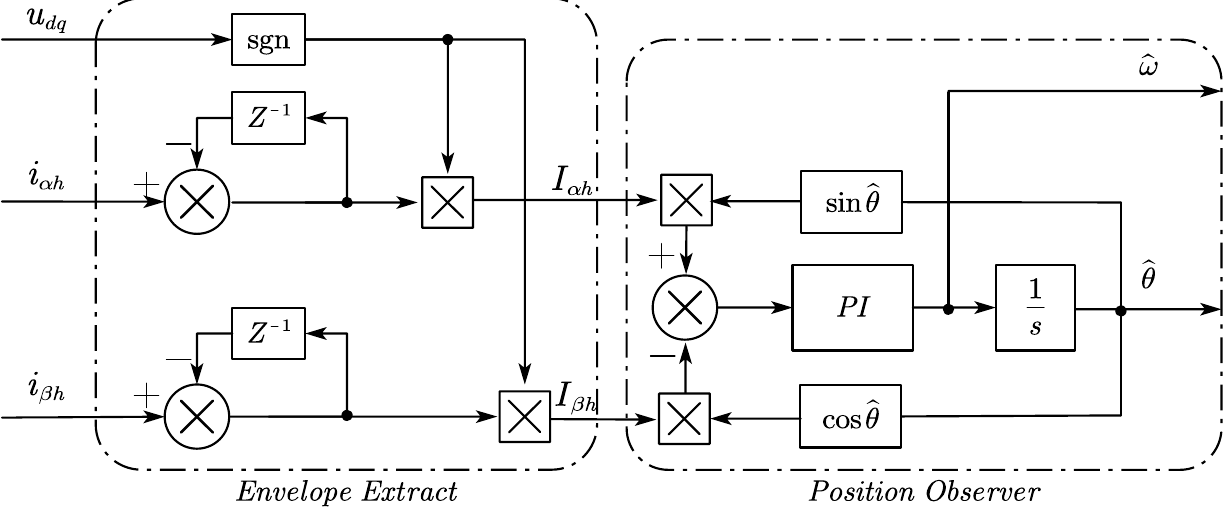
Figure 2. Sensorless rotor position